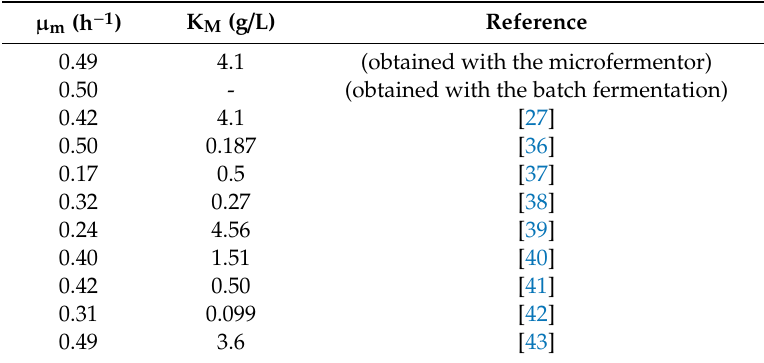
Table 2. Comparison between growth parameters obtained by the two methodologies to those reported in other researches. µ m (h − 1